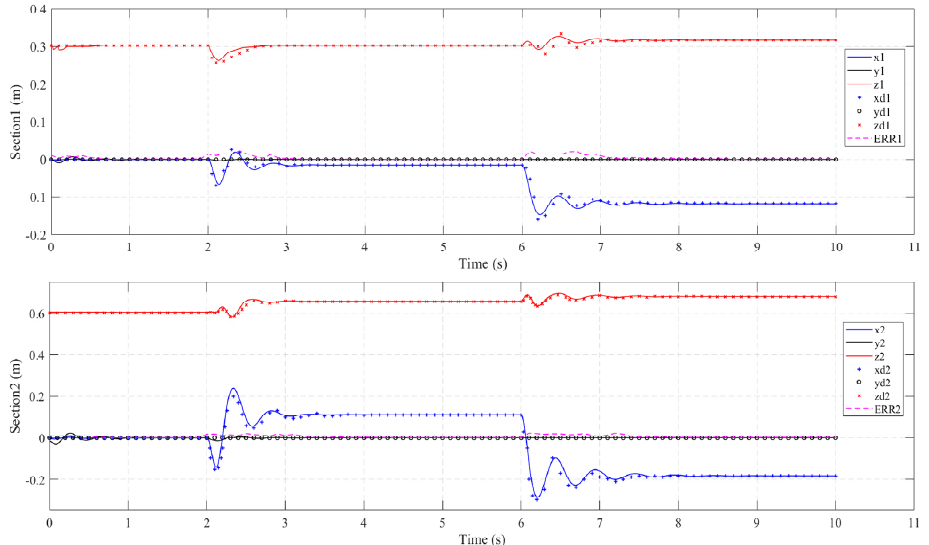
Figure 13. Sequential planar bending of all the sections. Comparison of the dynamic section tip co- ordinate evolution (solid line) vs. the corresponding coordinate values of the prototype arm (X, Y, and Z experimental data are denoted by o, +, and × marks, respectively). Position errors, ERR i = || ψ ie - ψ i || ∀ i ϵ {1,2}, are denoted by a dashed line in each subplot.